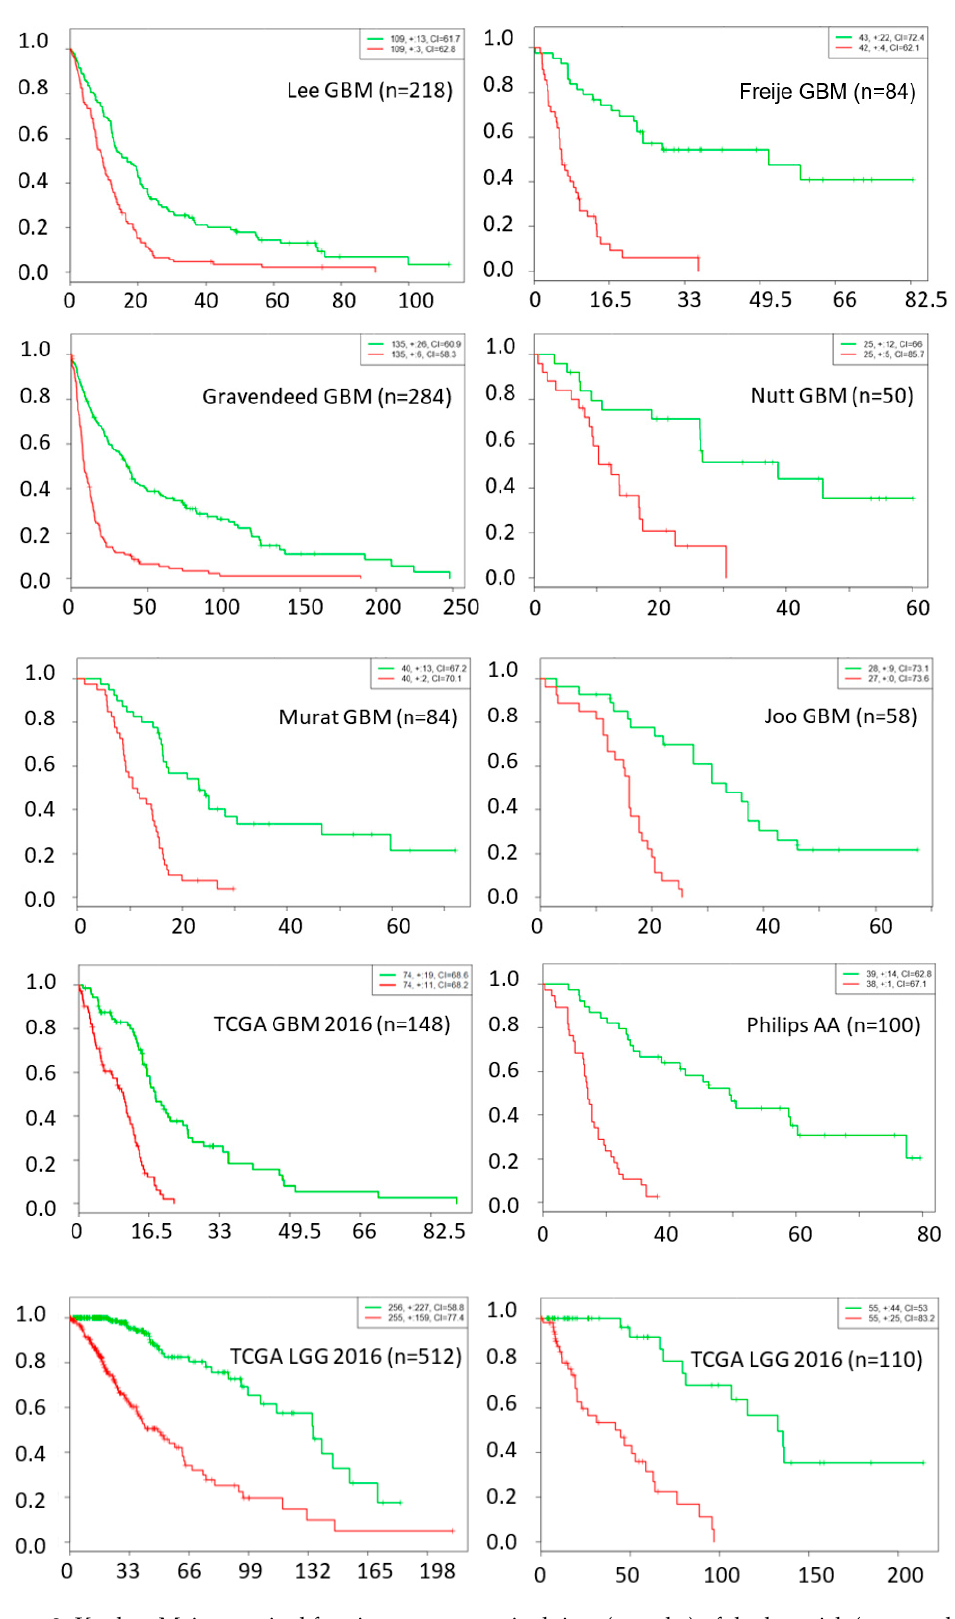
Figure 2. Kaplan–Meier survival fraction versus survival time (months) of the low-risk (green color) and high-risk (red color) groups are well separated using top 39 genes across nine different datasets, including data from seven glioblastoma and three low-grade glioma